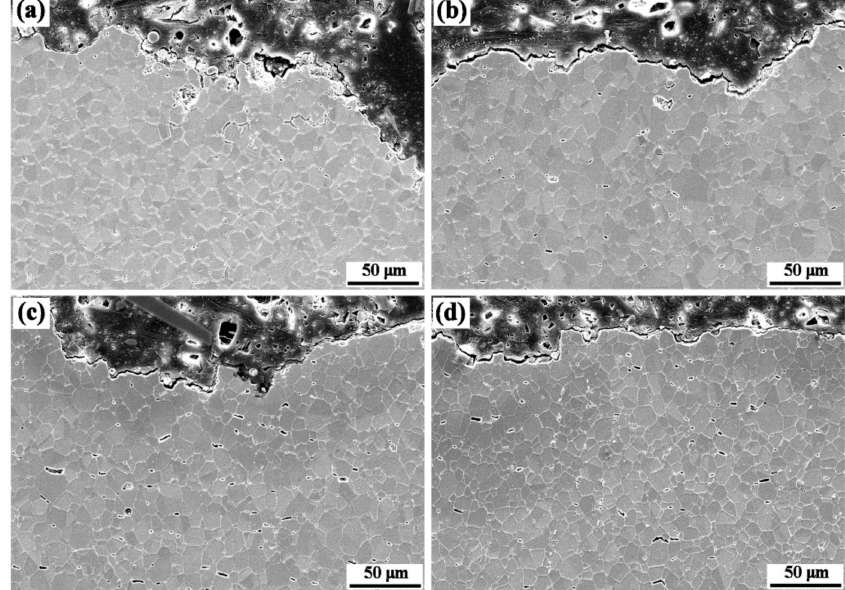
Figure 8. SEM micrographs of longitudinal sections ruptured at 650 ◦ C / 690 MPa: ( a ) alloy 1, ( b ) alloy 2, ( c ) alloy 3, and ( d ) alloy